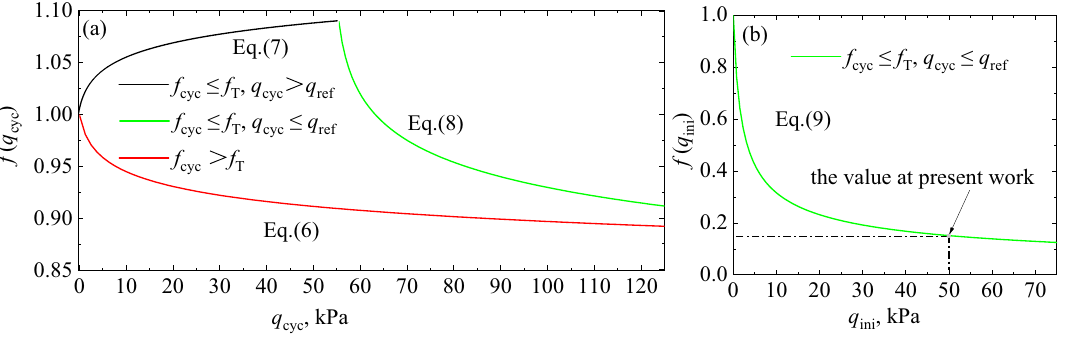
Figure 11. Dynamic stress level correction function: ( a ) focusing on Eqs. (6), (7), and (8); ( b ) focusing on Eq.